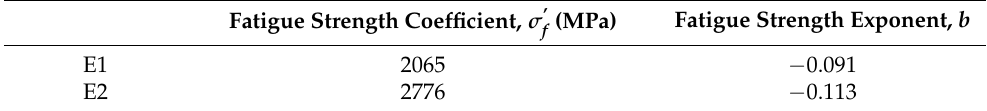
Table 4. Fatigue strength coefficient and exponent of E1 and E2